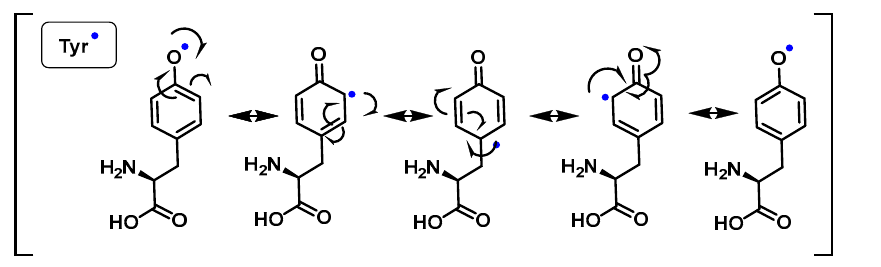
Figure 52. Resonant shapes of the Tyr • .